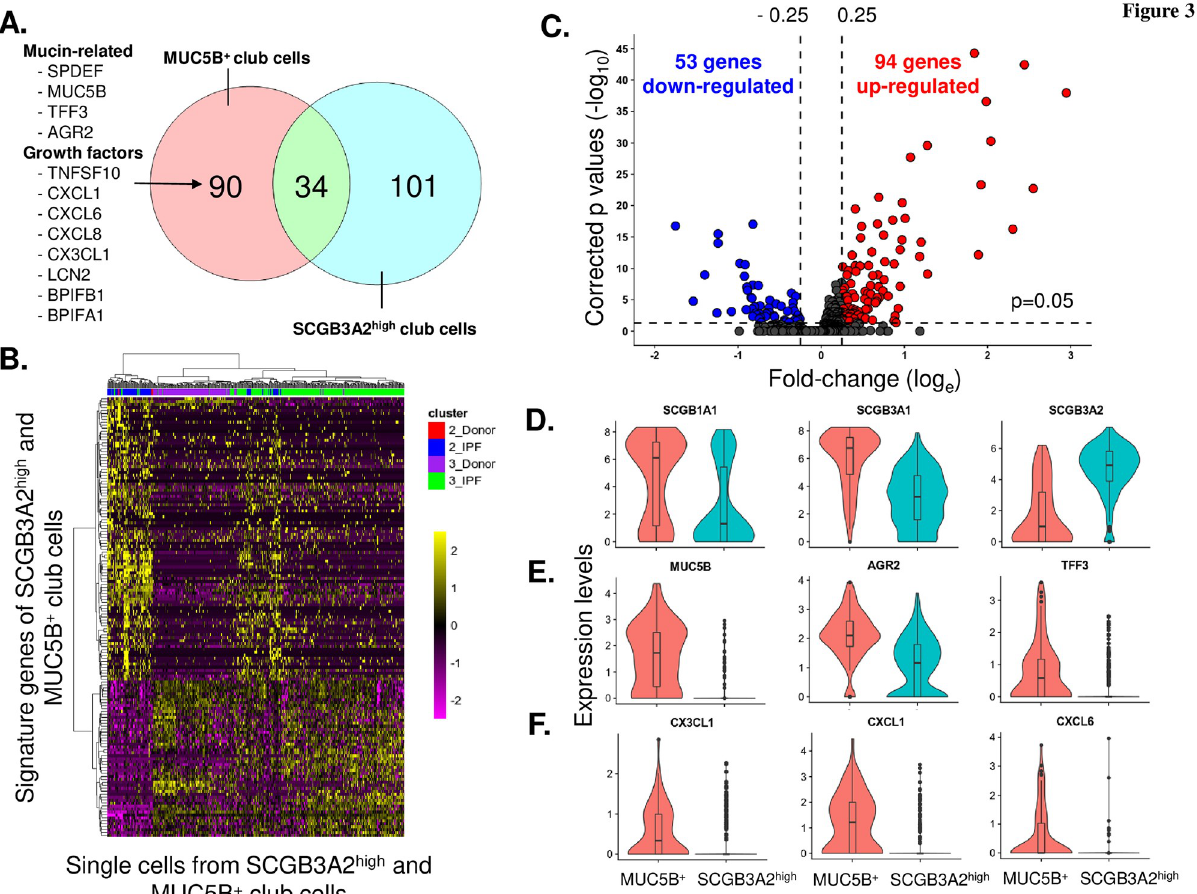
Fig 3. Transcriptomic differences between the club cell sub-populations. A. Venn diagram of the signature genes from club cell sub-populations. Left –signature genes of SCGB1A1 + MUC5B + club cells (n = 124), right –signature genes of SCGB1A1 + SCGB3A2 high club cells (n = 135), and overlap signature genes (n = 34). The SCGB1A1 + MUC5B + club cell unique signature genes related to mucin and growth factors are highlighted on the left of the Venn diagram. B. Heat map plot showing the expression of the signature genes in SCGB1A1 + SCGB3A2 high and SCGB1A1 + MUC5B + club cells. X-axis – signature genes, y-axis –single cells. Y-axis , red –control of SCGB1A1 + MUC5B + club cells; blue— IPF SCGB1A1 + MUC5B + club cells; purple –control SCGB1A1 + SCGB3A2 high club cells; and green— IPF SCGB1A1 + SCGB3A2 high club cells. C. Volcano plots of significantly down-regulated (53 genes, blue ) and up-regulated (94 genes, red ) genes in SCGB1A1 + MUC5B + club cells vs SCGB1A1 + SCGB3A2 high club cells. Y-axis –p values (-log 10 ), x-axis –the fold-change (log e ). Genes selected for analysis differed between populations by a fold-change (log e ) > 0.25 as the up-regulated genes or < -0.25 as the down-regulated genes (vertical dotted lines), and p < 0.05 with Bonferroni correction (horizontal line at y = 0.5). D. Violin plots of the expression of club cell genes (SCGB1A1, SCGB3A1 and SCGB3A2) in SCGB1A1 + MUC5B + and SCGB1A1 + SCGB3A2 high club cells. E. Violin plots in the expression of mucin-related genes (MUC5B, AGR2 and TFF3) in SCGB1A1 + MUC5B + and SCGB1A1 + SCGB3A2 high club cells. F. Violin plots in the expression